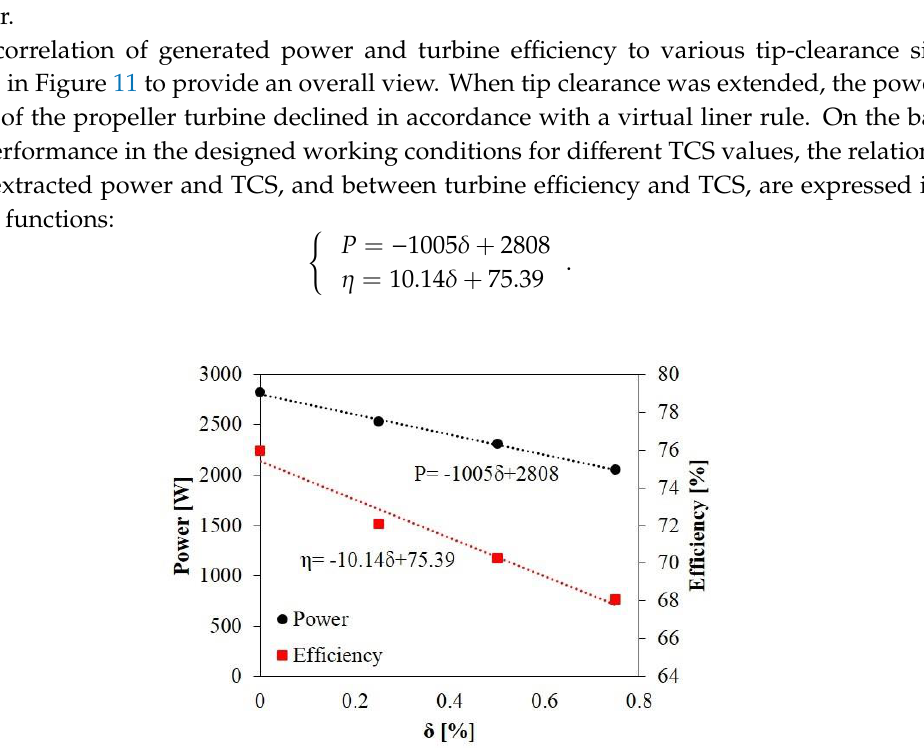
Figure 10. Variation of turbine-characteristic curves for different tip-clearance sizes. ( a ) Power vs. speed; ( b ) leakage volume and efficiency vs. speed.